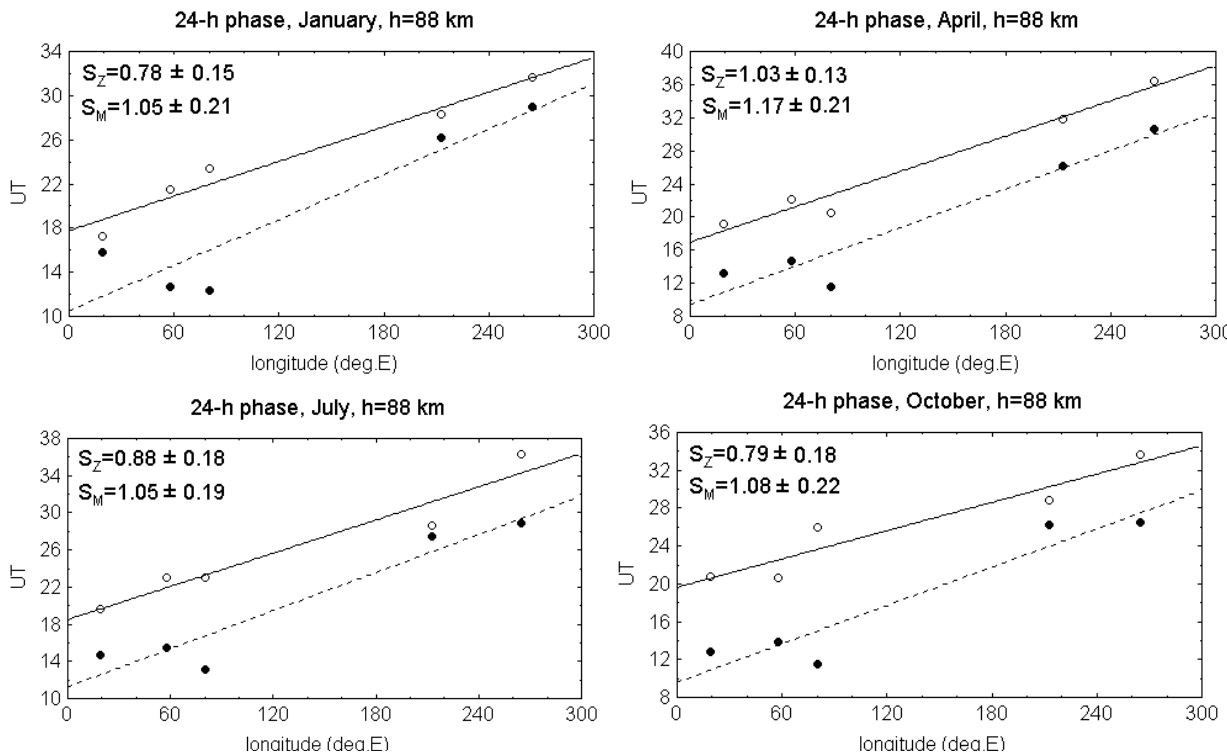
Fig. 14. Dependence of the DT phases (time of maximum in UT) on longitude. − o − zonal component, −•− meridional